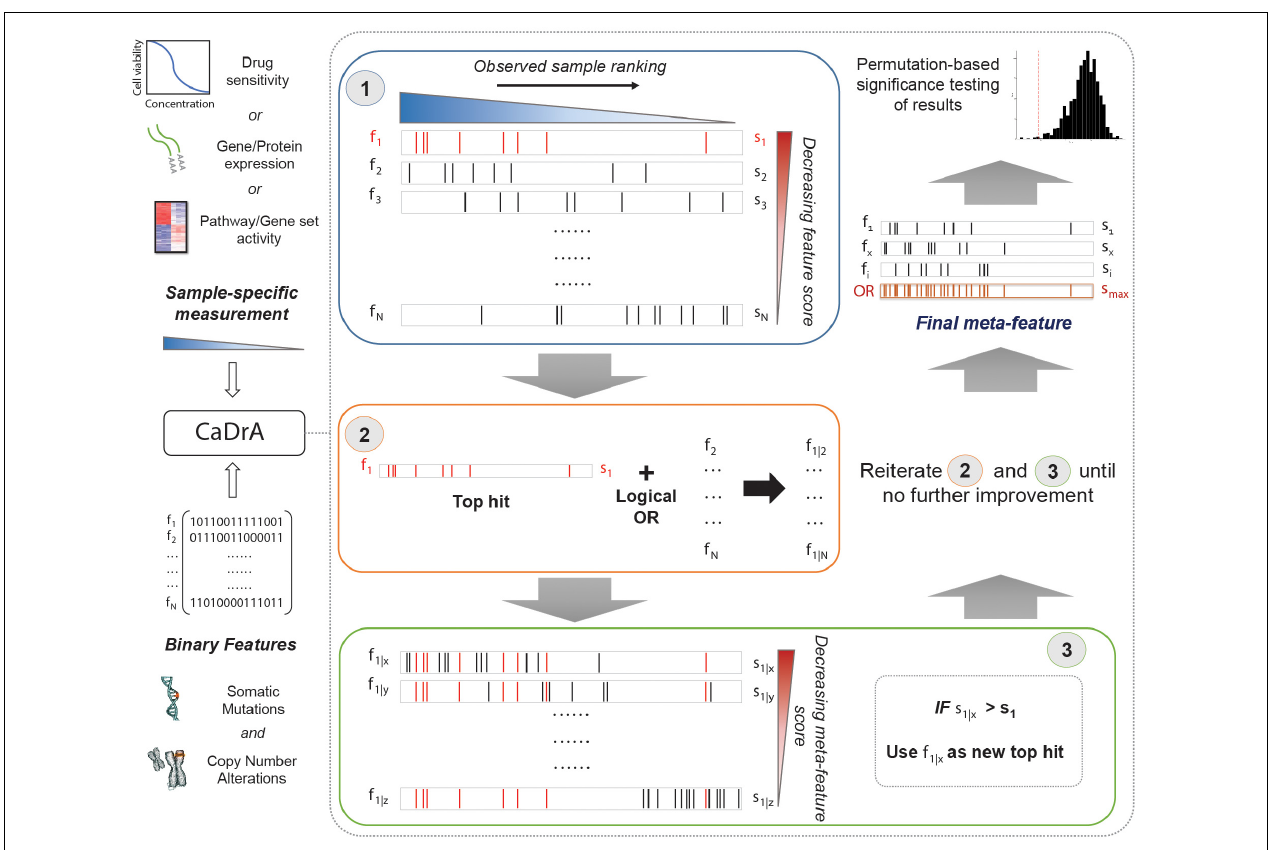
FIGURE 1 | Overview of CaDrA workflow and implementation. CaDrA takes as input a sample-specific measurement to rank samples, and a matrix of binary features of the same samples. In Step 1 (blue box), CaDrA begins by choosing a starting feature, which is either the single feature having the best score based on its left-skewness, or a user-specified start feature. In the next step (Step 2; orange box), the union (logical OR) of this feature with each of the remaining features in the dataset is taken, yielding ‘meta-features’ with their corresponding scores. If any meta-feature has a better score than the hit from the previous step (Step 3; green box), CaDrA uses this new meta-feature as a reference for the next iteration, repeating Steps 2 and 3 until no further improvement in scores can be obtained. The final output is a set of features (meta-feature) whose union has the (local) maximum score and its permutation-based p